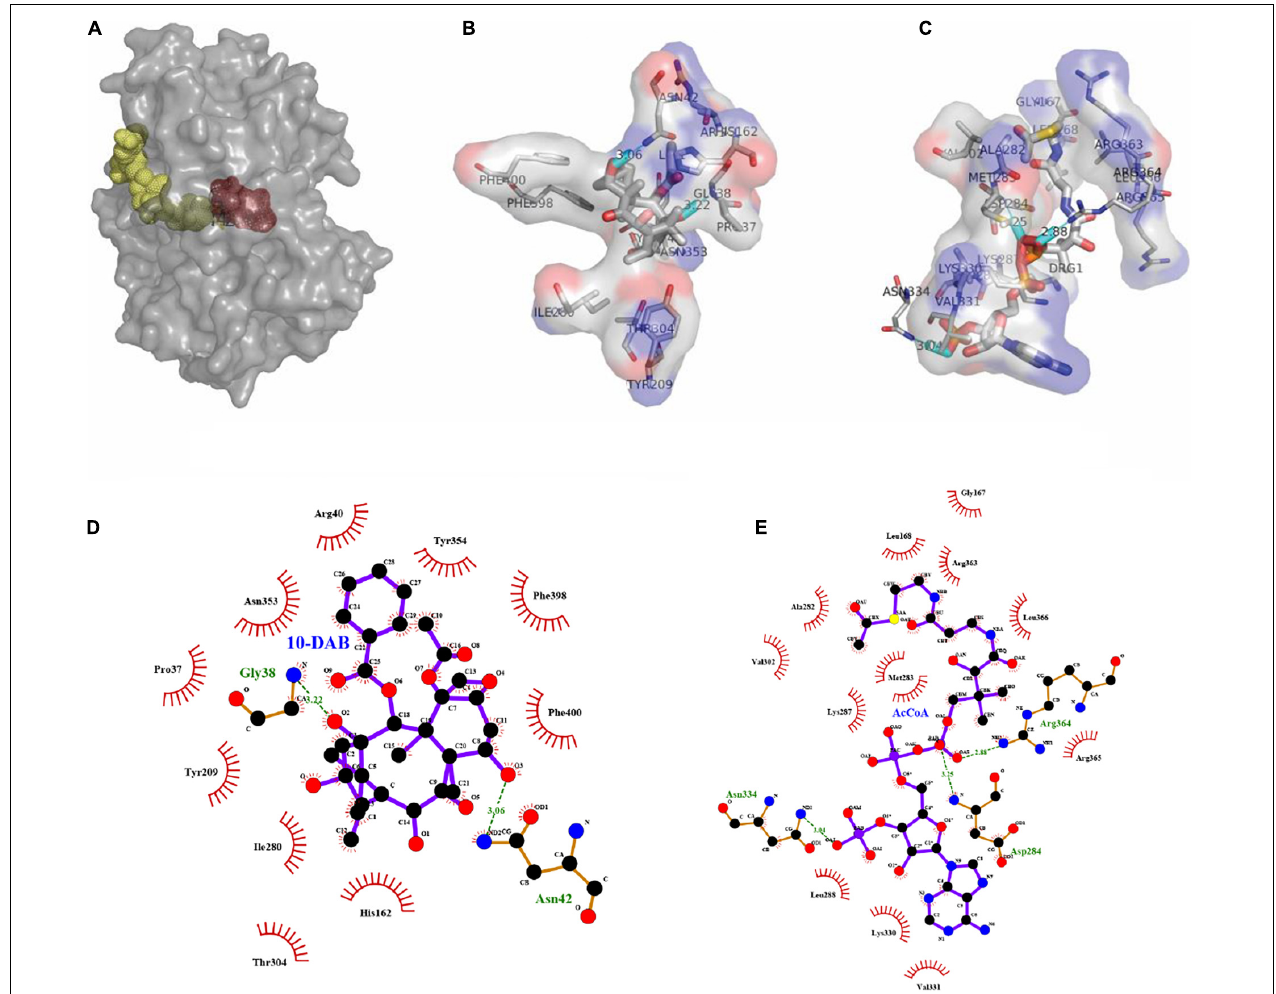
FIGURE 5 | Molecular docking results of WT and two substrates. The complex was named WT_10-DAB_AcCoA. (A) Panoramic conformation of WT_10-DAB_AcCoA. (B) Interaction between 10-DAB and WT in 3D-model. (C) Interaction between acetyl-CoA and WT in 3D-model. (D) The hydrogen bonds were shown as green dotted lines between 10-DAB and WT. (E) The hydrogen bonds were shown as green dotted lines between acetyl-CoA and WT.